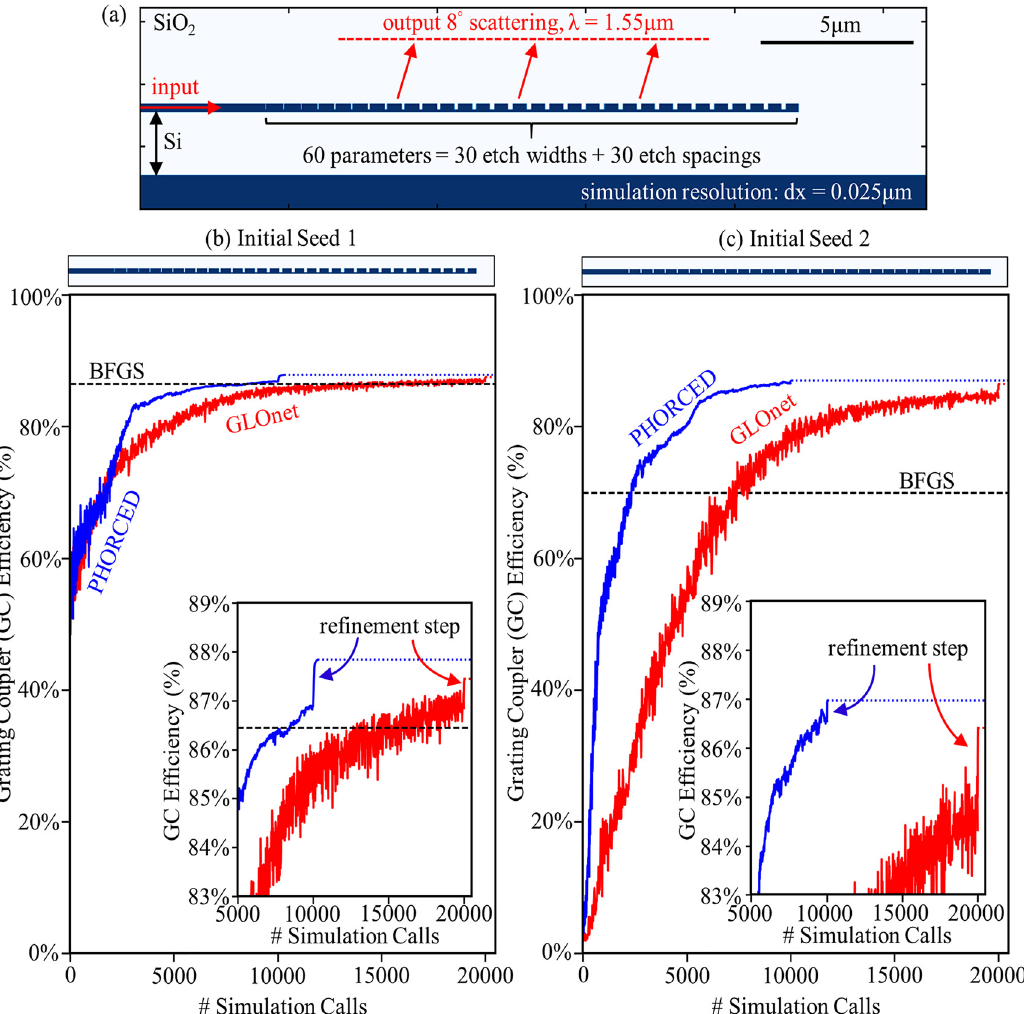
Figure 2: PHORCED and GLOnet outperform conventional gradient-based optimization, with different simulation evaluation requirements. The grating coupler simulation geometry for optimization is shown in (a), consisting of an SOI wafer platform with 280 nm waveguide, 190 nm etch depth, and 2 μ m BOX height. We optimized 60 device parameters in total, namely the width and spacing between 30 etch corrugations. The results of the BFGS, GLOnet, and PHORCED algorithms applied to Initial Seed 1 and Initial Seed 2 are presented in (b) and (c) as a function of the number of simulation calls. The initial seeds (grating designs) are illustrated above each optimization plot. The insets depict zoomed-in views of the peak efficiencies attained by PHORCED and GLOnet, along with respective BFGS refinement steps performed on the best design generated by each